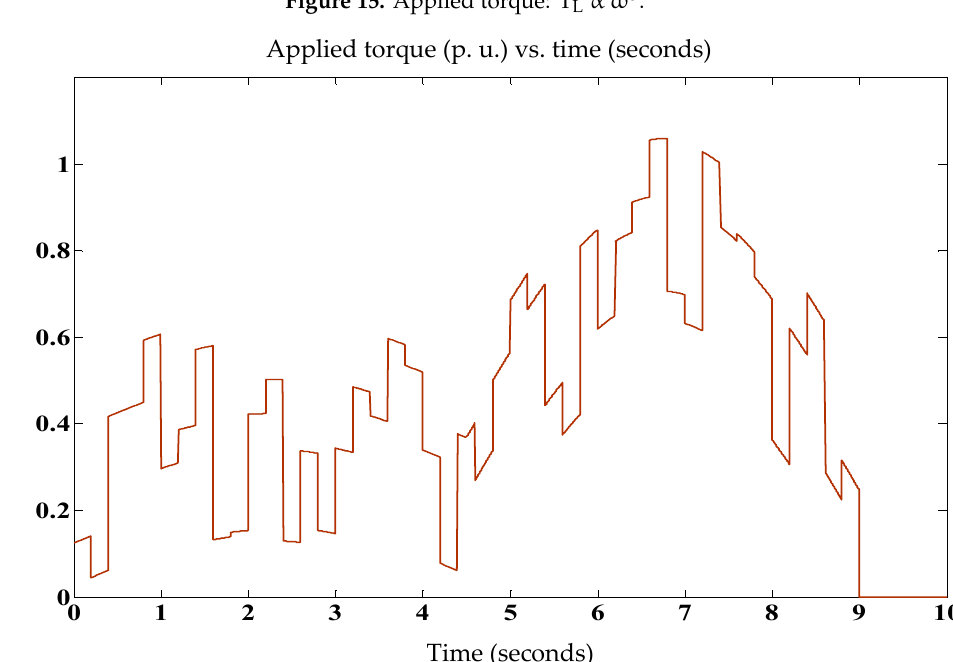
Figure 15. Applied torque: T L α ω 3.